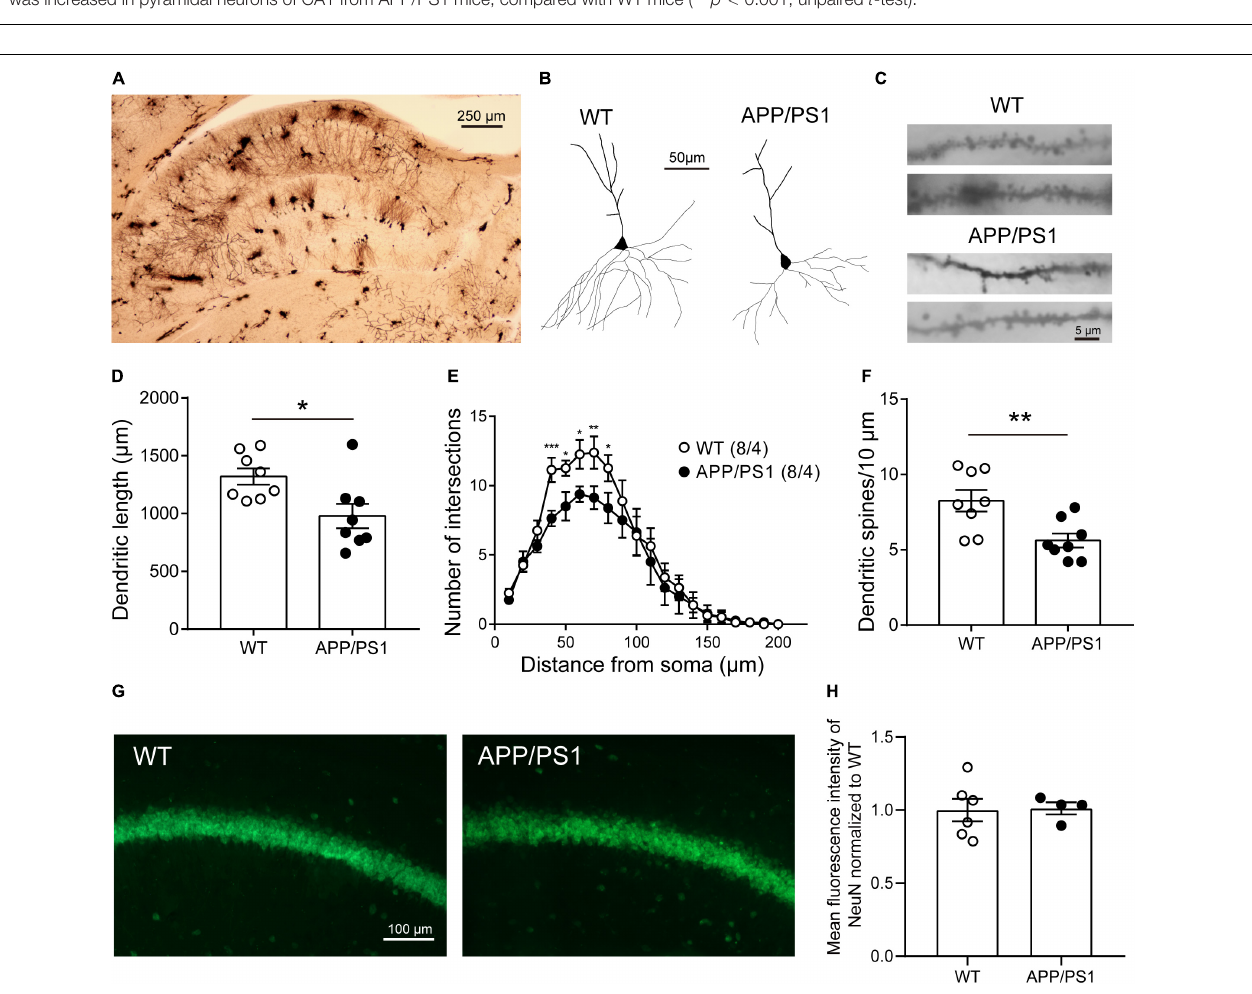
FIGURE 4 | contribution decayed to zero. Dotted lines represent the time window in which the NMDAR sEPSCs charge was calculated. (G) The NMDAR sEPSCs charge was reduced in the cells from APP/PS1 ( n = 10–12 cells from 4 to 6 mice/group; *** p < 0.001, unpaired t -test). (H) The AMPAR/NMDAR ratio of sEPSCs was increased in pyramidal neurons of CA1 from APP/PS1 mice, compared with WT mice (*** p < 0.001, unpaired t -test).